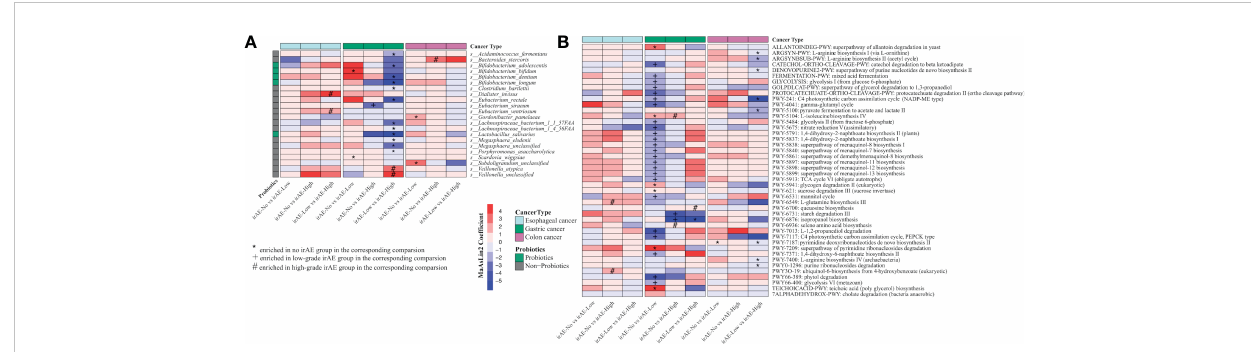
FIGURE 4 Signi fi cantly differential species and metabolic pathways in patients with different cancer types strati fi ed by irAE severity. (A) Differential species between each comparison (irAE groups: irAE_No, irAE_Low and irAE_High) for esophageal cancer, colon cancer, and gastric cancer patients. Commonly considered probiotic species (green color) based on Probio https://bidd.group/probio/homepage.htm. (B) Differential metacyc pathway between each comparison (irAE groups: irAE_No, irAE_Low and irAE_High) for esophageal cancer, colon cancer and gastric cancer patients. MaAsLin2 was used to identify differential species and pathway between irAE groups. Each column indicates a comparison, and the labels (*,#,+) indicate the direction of enrichment. Different colors of the rows indicate different cancer